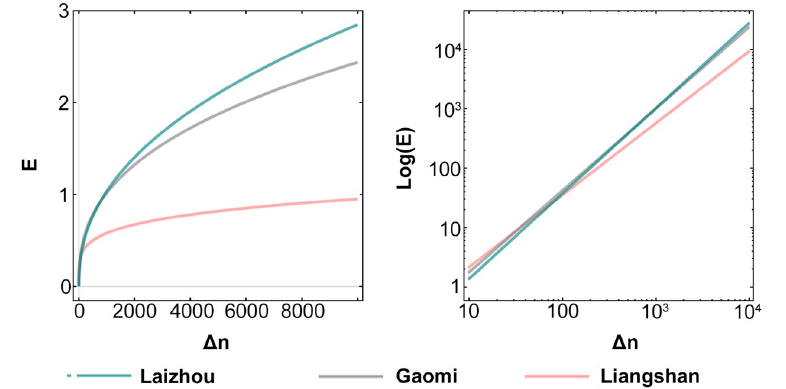
Fig 5. Relationship between the increase in population and GDP of Laizhou, Gaomi, and Liangshan.